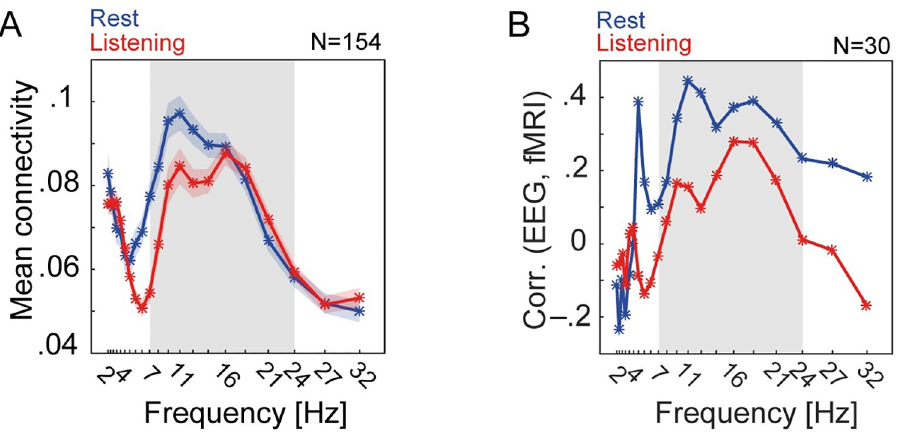
Fig 3. Spectral profile of source EEG power-envelope correlations and their relationship with fMRI connectivity. (A) Frequency-specific whole-brain mean connectivity during rest and listening task. At each frequency and per individual, mean connectivity was estimated as the upper-diagonal average of power-envelope correlation matrix thresholded at 10% of network density. Each line graph represents mean ± SEM of mean connectivity across all N = 154 participants. (B) Thirty participants have had performed the same task in fMRI [5]. Across these participants, we tested the correlation between whole-brain mean connectivity derived from brain hemodynamics (i.e., mean Pearson correlation between fMRI band-passed filtered [0.06–0.12 Hz] BOLD signals) and whole-brain mean connectivity derived from EEG oscillatory source activity (i.e., mean power-envelope correlation at frequencies ranging from 2–32 Hz). Power-envelope correlations between EEG oscillatory sources show strongest positive correlation with fMRI connectivity within alpha and low-beta frequency range (gray frequency intervals). The data underlying this figure can be found at https://osf.io/ge2cq/. EEG, electroencephalography; fMRI, functional magnetic resonance